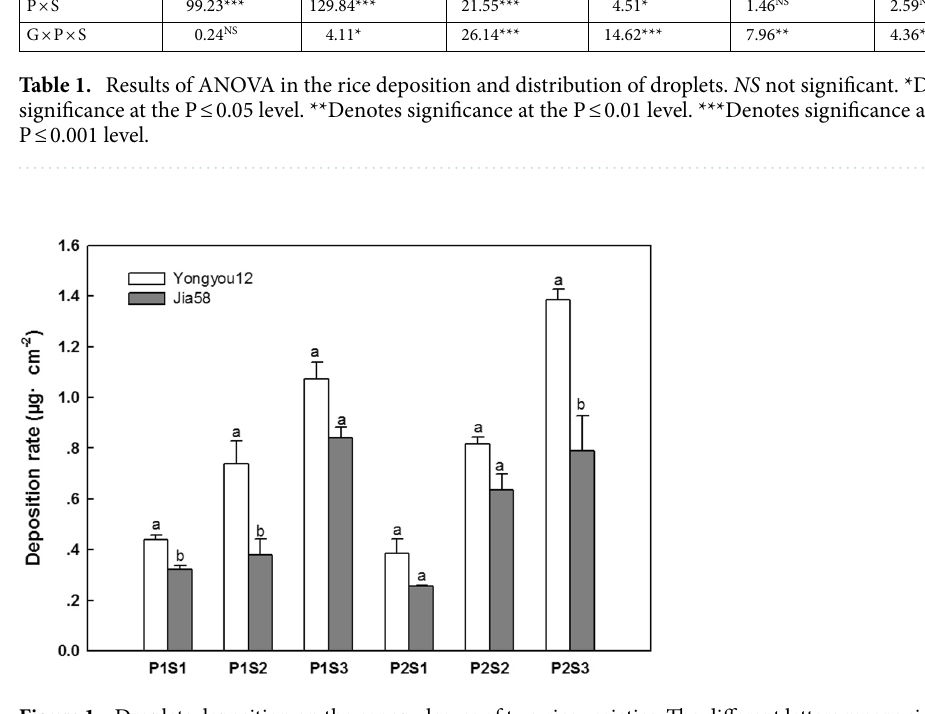
Figure 1. Droplets deposition on the canopy leaves of two rice varieties. The different letters means significant difference ( P ≤ 0.01) by